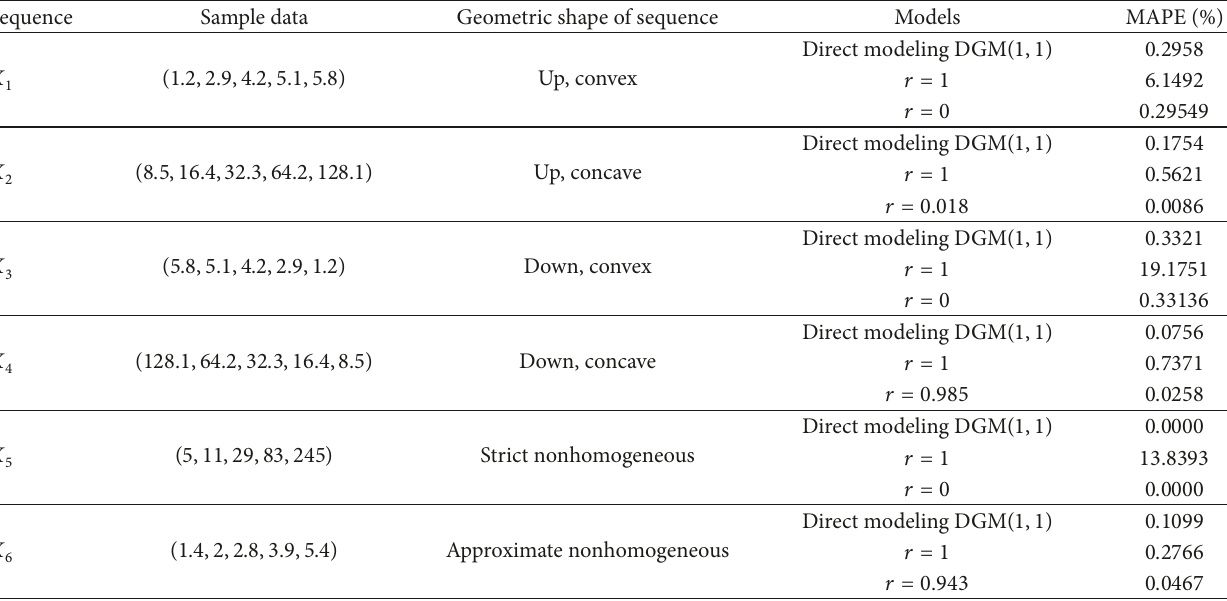
Table 2: The fitted values and MAPE of different discrete grey